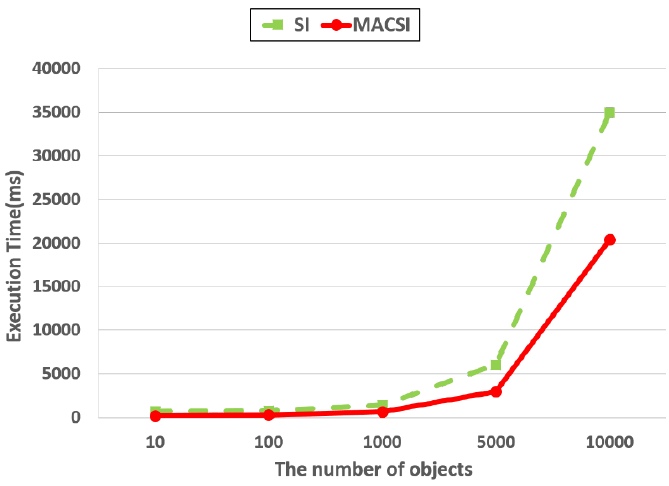
Figure 26. The effect of cell number on the semantic trajectory query performance.